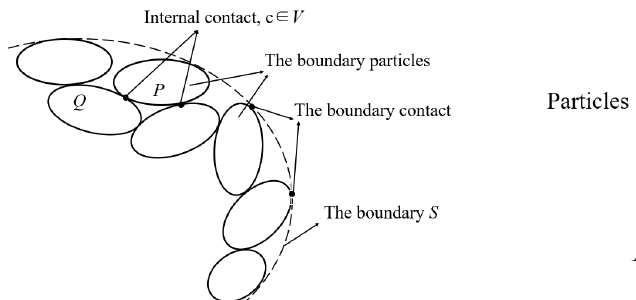
( b ) Water absorption rate and deformation rate Figure 12. Relationship between pore area and deformation. The pore area of mudstone has a greater connection with water absorption rate and deformation rate, showing that rock samples with small pore areas have large water ab- sorption rate and large deformation rate (Figure 12b). After the rock sample with small pore area is exposed to water, the pore area will develop rapidly, providing water con- duction area for water absorption and deformation when the reaction rate is positively correlated with the water conduction area.